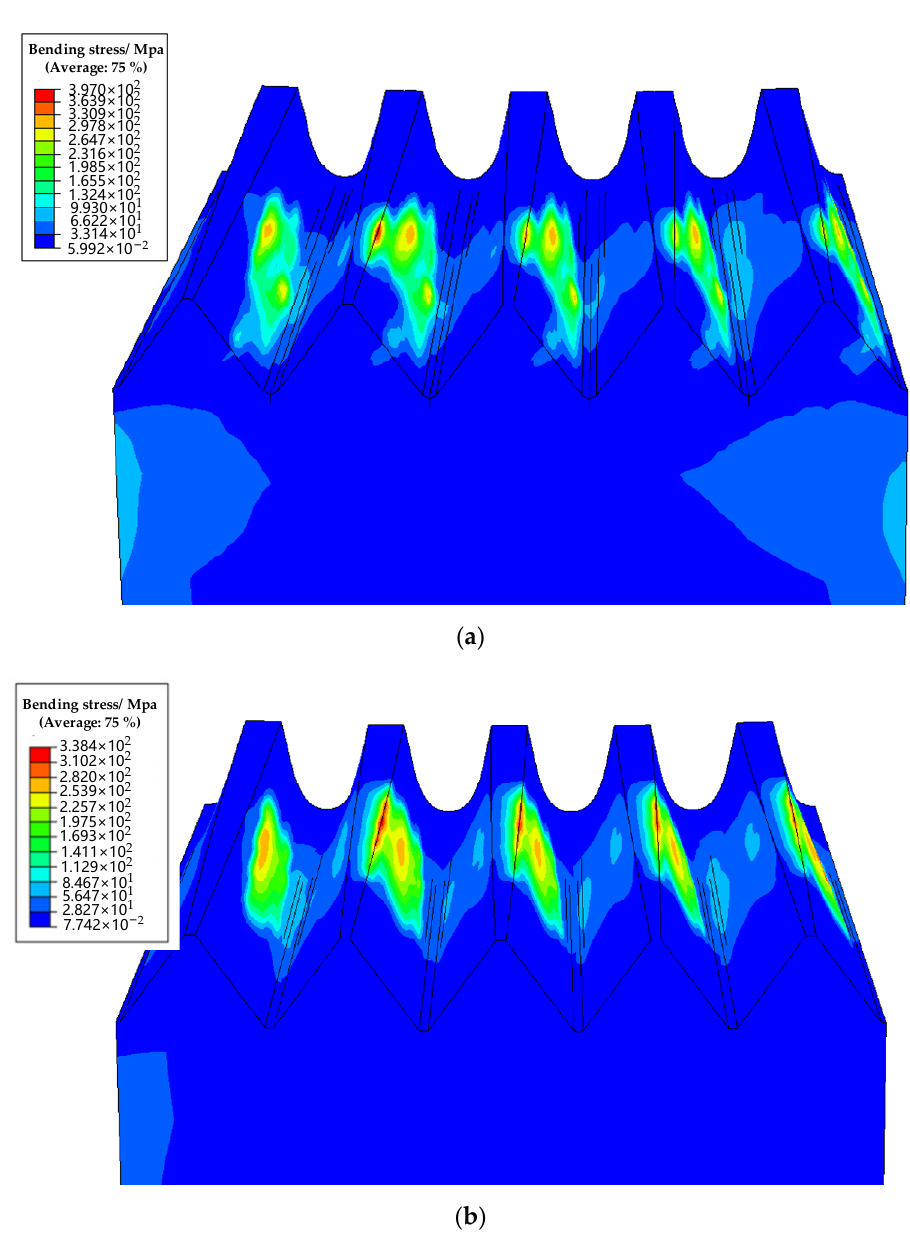
Figure 12. The simulation results for the bending stress of ( a ) the real face gear drive and ( b ) the designed face gear drive.